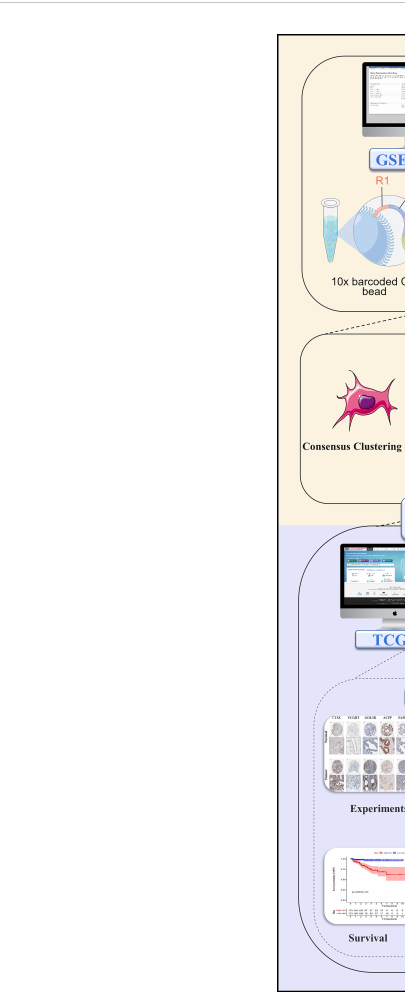
FIGURE 1 The fl ow chart of the present study. Mining MRMGs through scRNA-seq data to construct a MRMGPS to predict prognosis, analyze TME, and select drugs in PCa. TCGA, The Cancer Genome Atlas; scRNA-seq, single-cell RNA-sequencing; MRMGs, macrophage-related marker genes; MRMGPS, macrophage-related marker gene prognostic signature; TME, tumor microenvironment; PCa, prostate